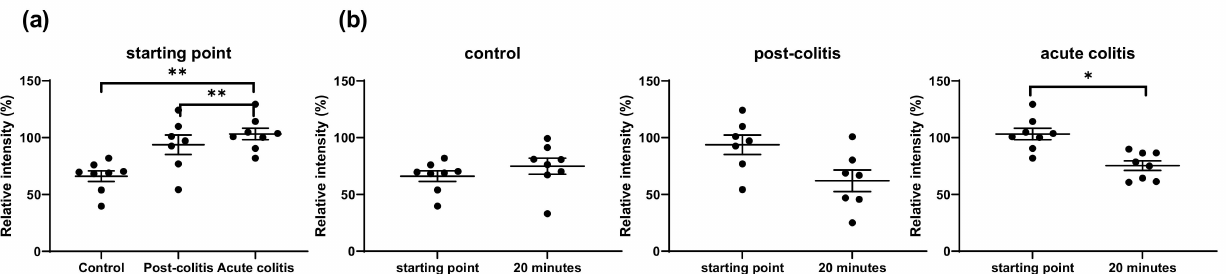
Figure 3. ( a ) Relative intensity of the full-length neurotensin at the starting point, after seconds of incubation with samples from control, post-colitis and acute colitis rats. Statistics: Kruskal–Wallis test post hoc Dunnett–Bonferroni. ( b ) Relative intensity of the full-length neurotensin at the starting point and after 20 min of incubation with control, post-colitis and acute colitis samples. The decrease of the full-length peptide is significant in acute colitis samples but not in control or post-colitis samples. Statistics: Wilcoxon signed-rank test. The mean and standard error of the mean (SEM) are shown. n = 8 animals per group * p < 0.05 ** p <